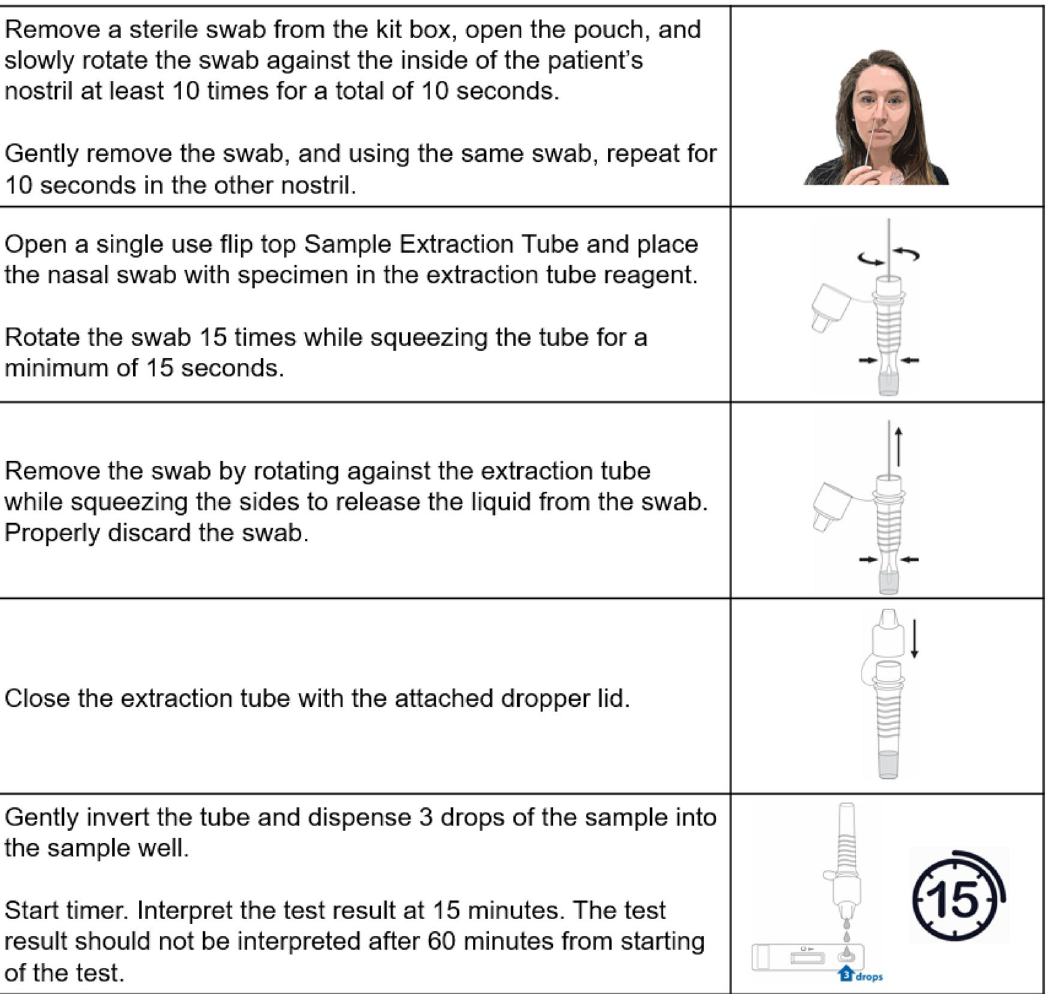
Figure 2. Pictorial description of SARS-CoV-2 antigen RDT intended sample testing